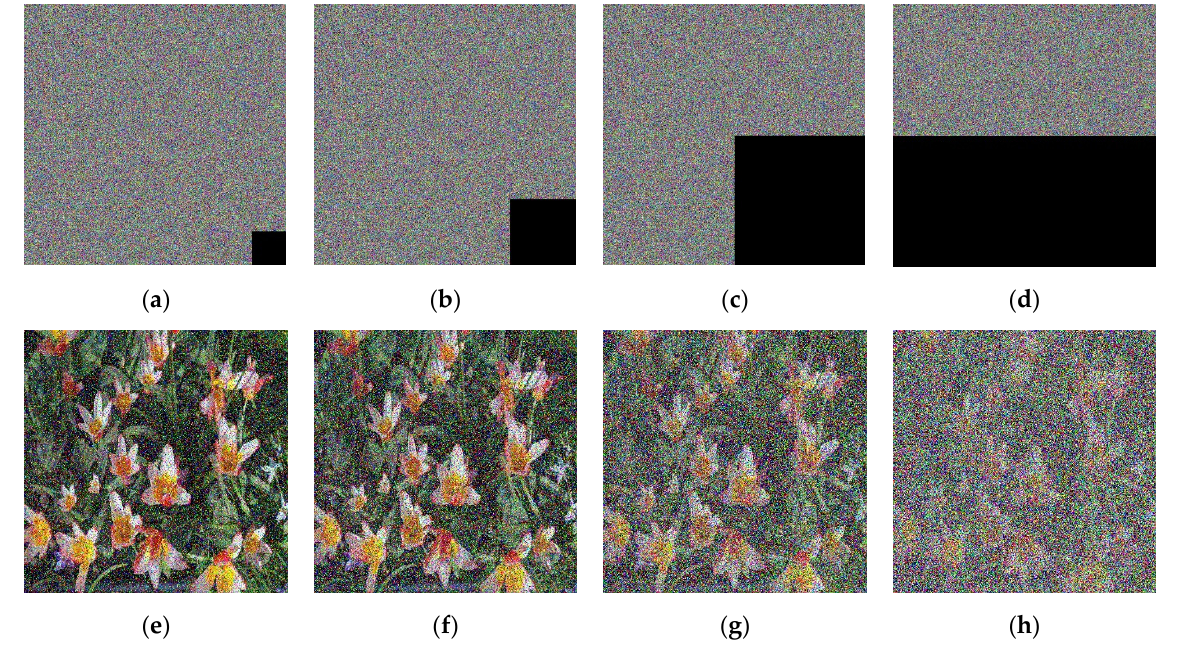
Figure 6. Enciphered and deciphered images after ( a ) 1/64 occlusion; ( b ) 1/16 occlusion; ( c ) 1/4 occlusion; ( d ) 1/2 occlusion; ( e ) deciphered image after 1/64 occlusion; ( f ) deciphered image after 1/16 occlusion; ( g ) deciphered image after 1/4 occlusion; ( h ) deciphered image after 1/2 occlusion. Table 7. Execution time (in seconds) of the proposed cryptosystem. Image